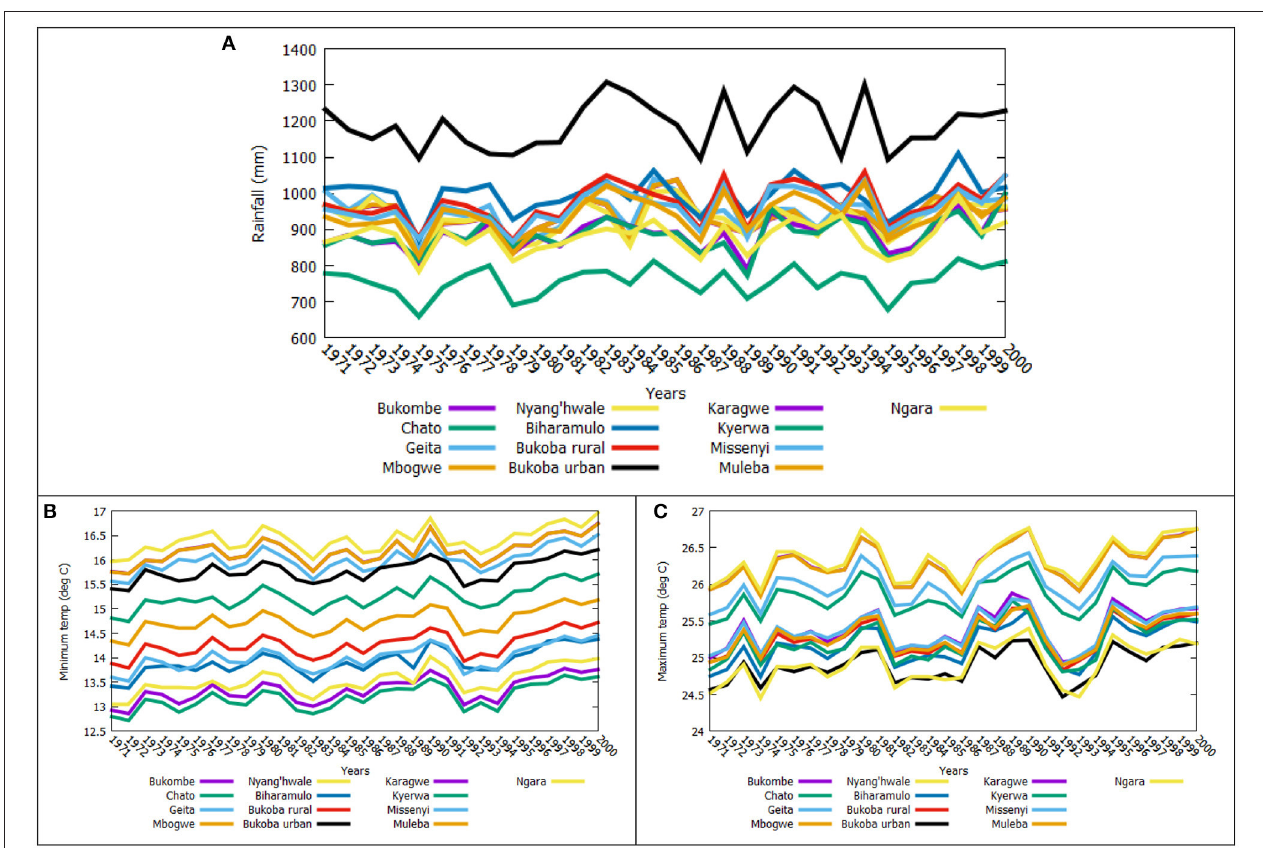
FIGURE 4 | The interannual variation in rainfall and minimum and maximum temperature. (A) Annual rainfall. (B) Annual minimum temperature. (C) Annual maximum